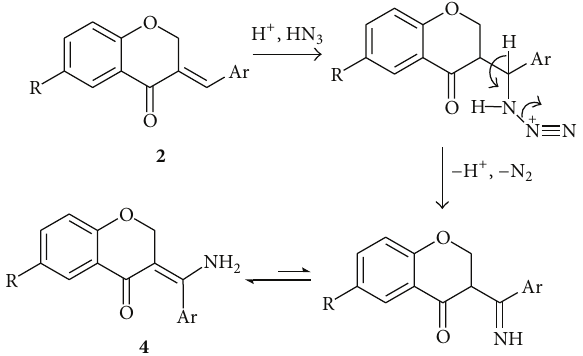
Scheme 3: Suggested mechanism for formation of 4